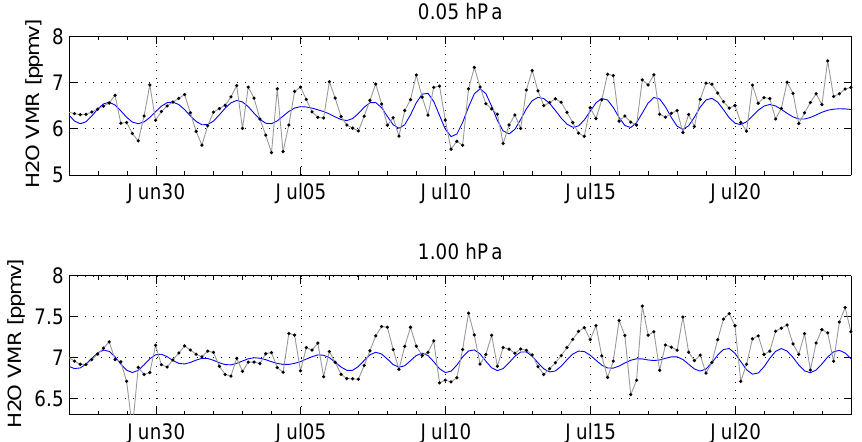
Figure 5. Measured water vapour data (black dots and grey lines) and filtered Q2DW signal (blue lines) for 0.05 and 1hPa for July 2012. The mean value over the time period has been added to the filtered signal and contributions with periods of 5, 10 and 16days have been subtracted from the measurement. In summer, the Q2DW is strong at 0.05hPa but cannot explain the observed variations with periods shorter than 5 days on